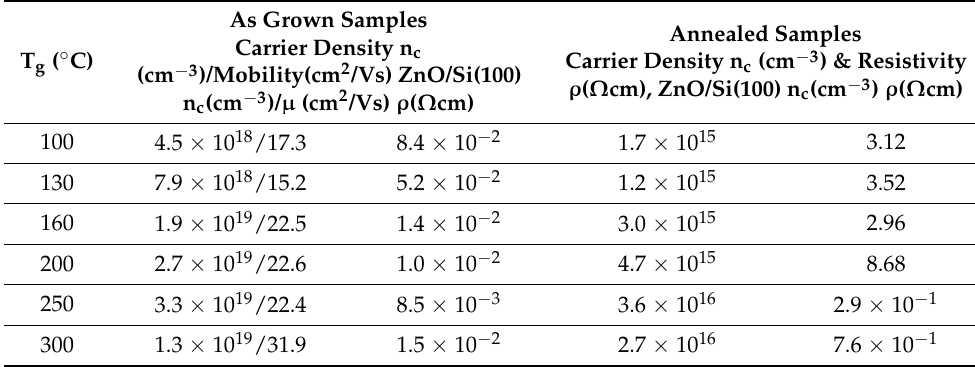
Table 4. Electrical parameters and thickness of as grown and annealed ALD- ZnO/Si(100) thin films (mobility of annealed samples is not included, see explanation in the text, p . 14, lines 506–508). As Grown Samples T g (°C ) Carrier Density n c (cm −3 )/Mobility(cm 2 /Vs)